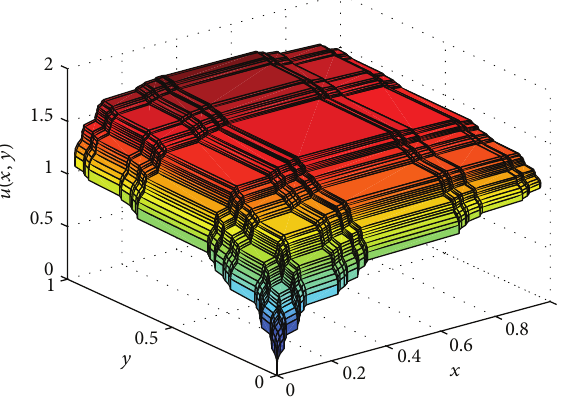
Figure 1: The plot of the solution of (9) with the local fractional derivative boundary value conditions (27) when 𝛼 = ln 2/ ln 3 .